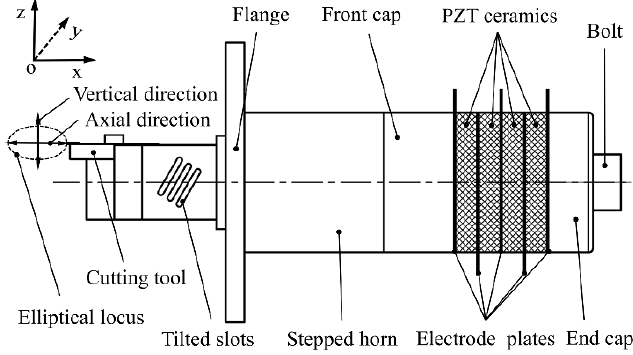
Figure 1. Design of the proposed device.